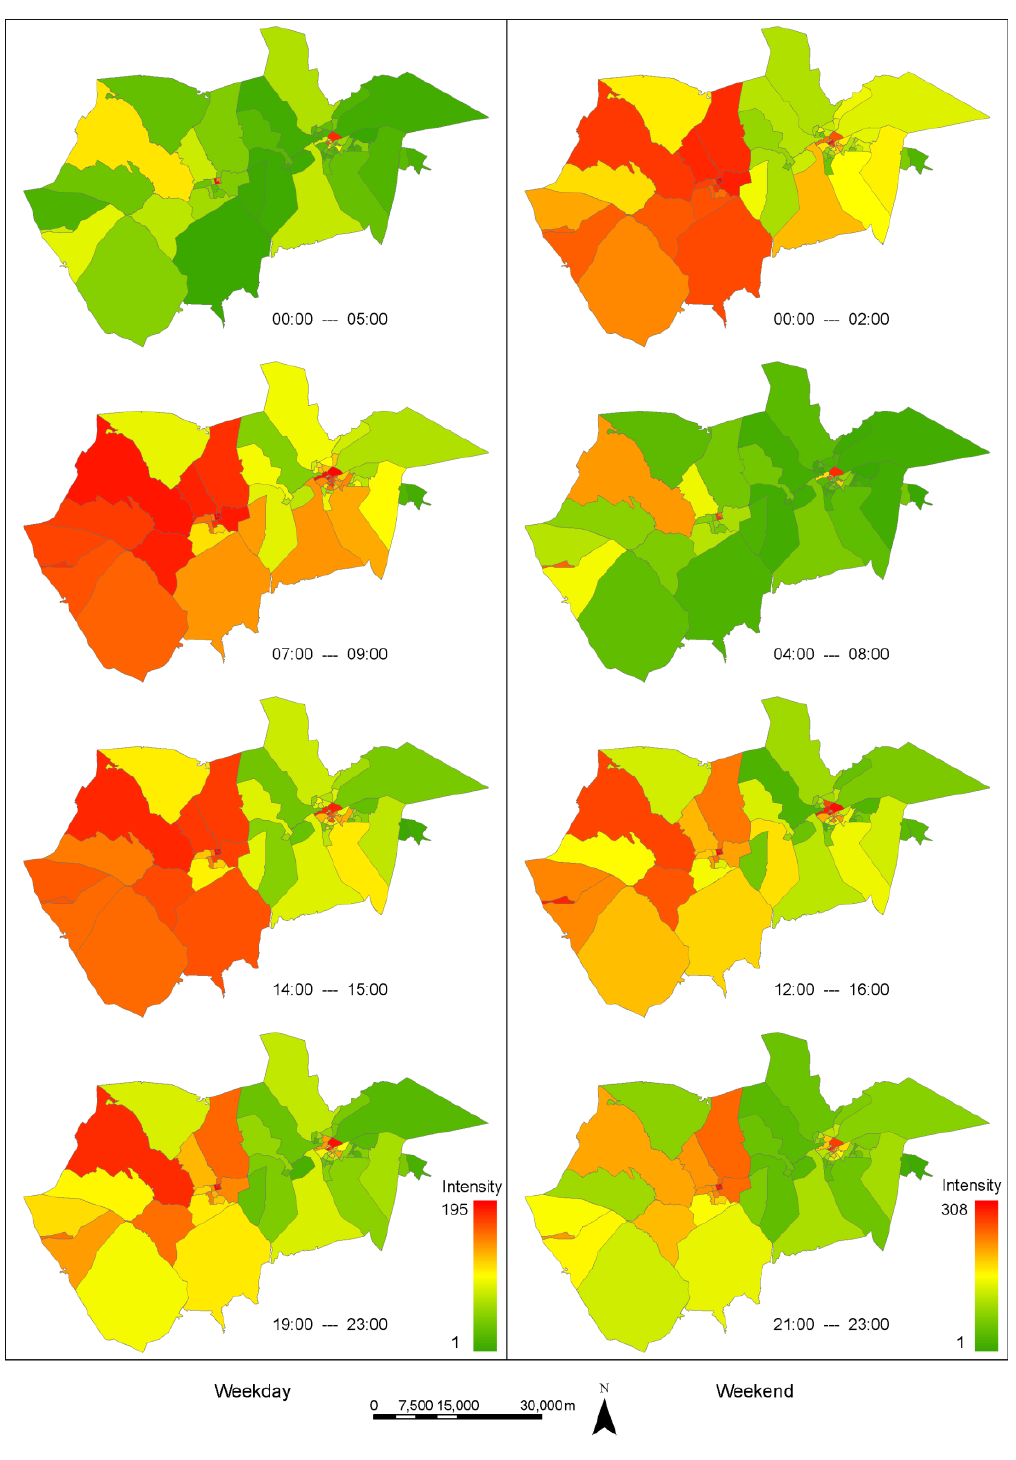
Figure 6. Map of the intensity of activities changing with time on an hourly